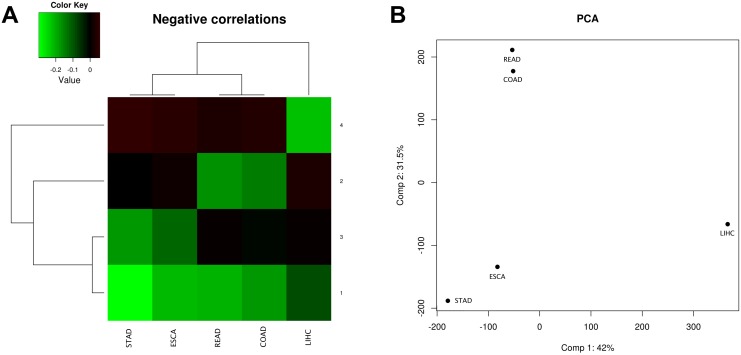
Clustering and Principal Components Analysis of the five digestive cancers.Computations are based on the correlation coefficients of the 106.426 miRNA-mRNA pairs that are expressed across all five cancer data sets. A) Heatmap showing the centers of the different clusters. Values represent the mean of the Pearson correlation coefficient of the miRNA-mRNA pairs that fall into the cluster. B) Principal Components Analysis (based on correlation matrix) of the Pearson correlation coefficient of the miRNA-mRNA pairs from the five digestive cancer data sets.